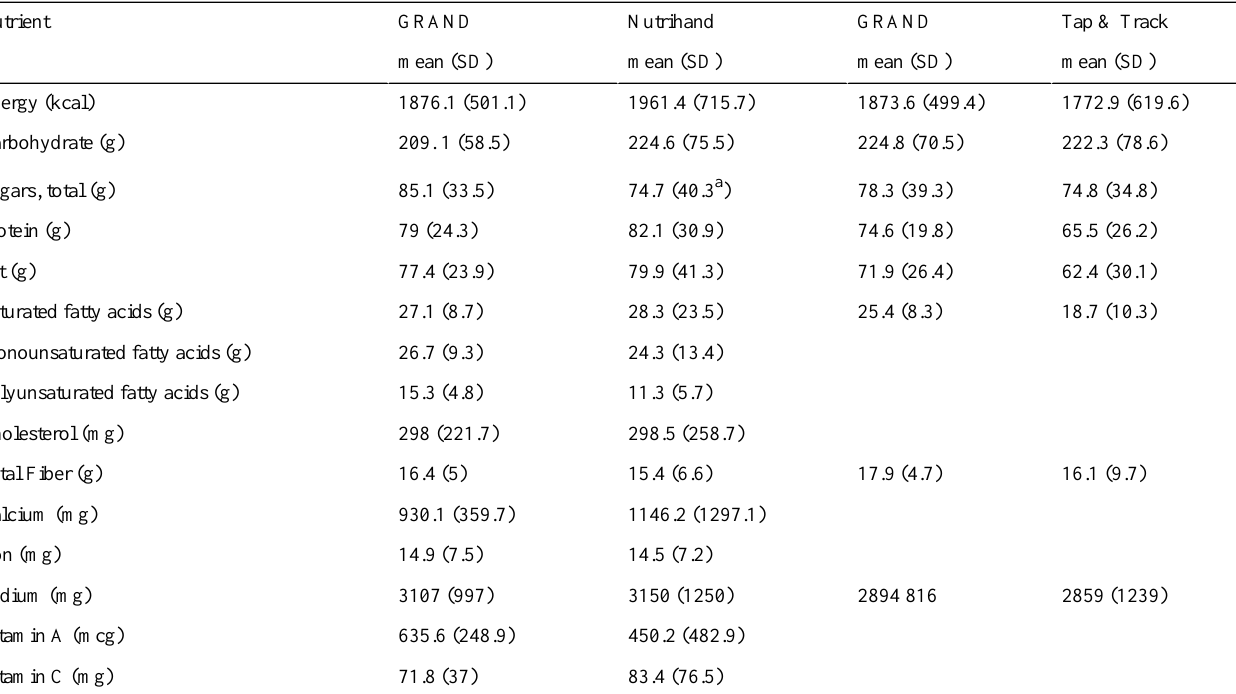
Table 1. Reported nutrient intake for GRAND and Nutrihand, and GRAND and Tap & Track.